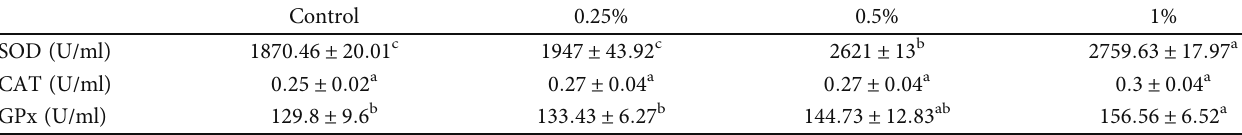
Table 4: The e ff ects of di ff erent levels of U. intestinalis on antioxidant defence of zebra fi sh. Control 0.25%